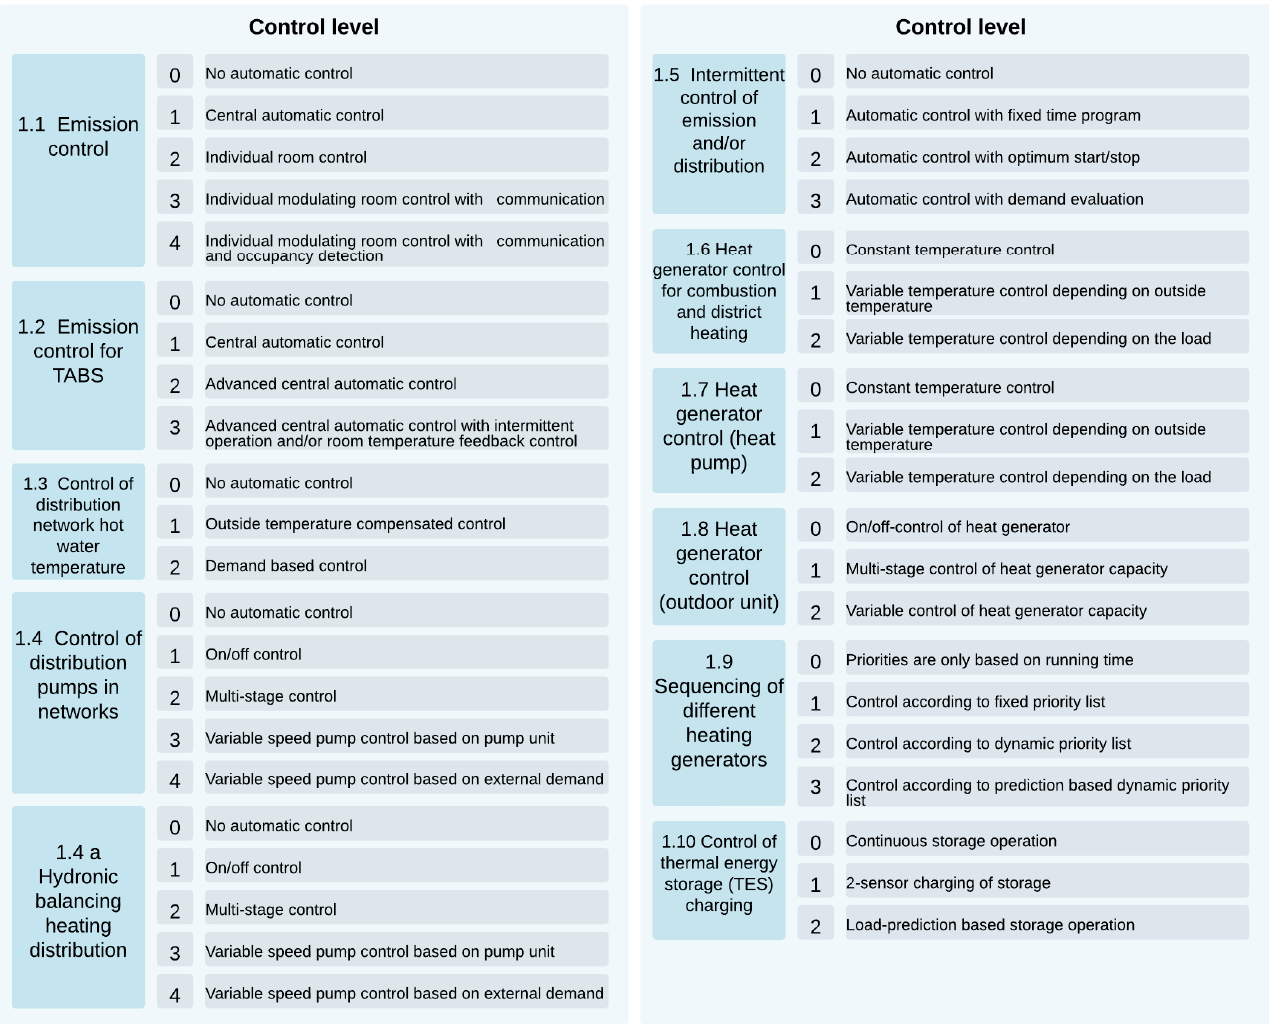
Figure A1. BAC and TBM functions with an impact on the energy performance of buildings for heating control [8].